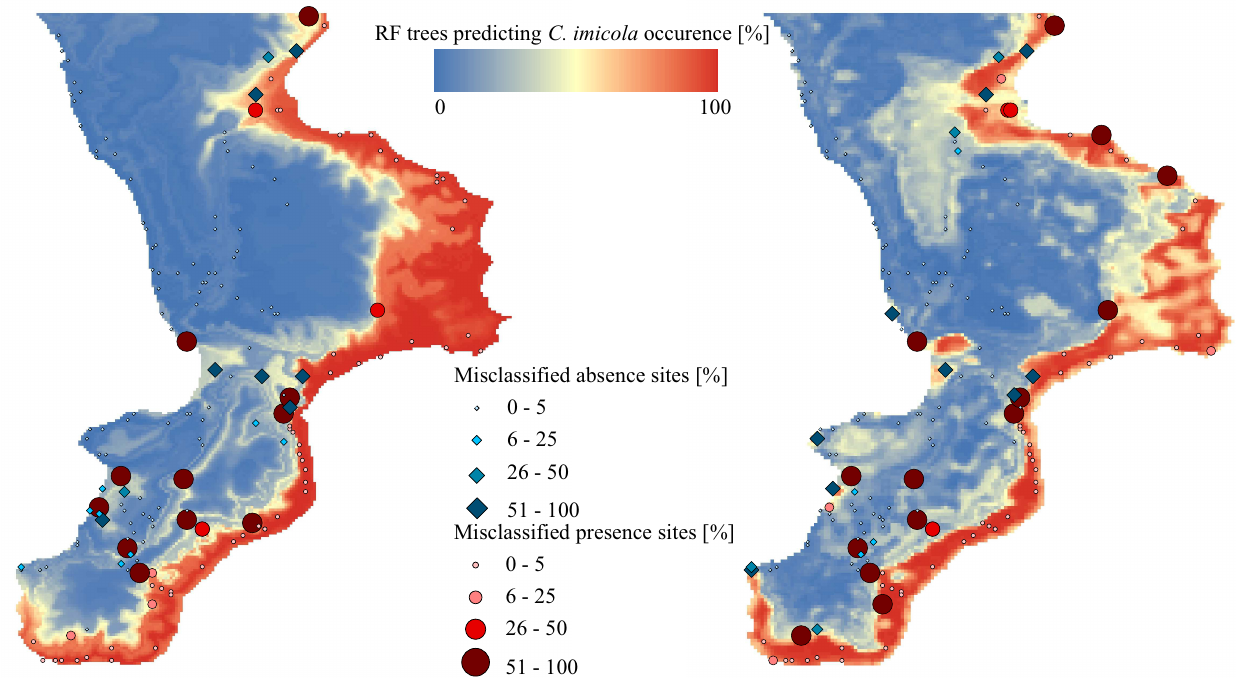
Percentage of RF trees assigning C. imicola occurrence and percentage of misclassifications at absence and presence sites, based on climatic data ( left ) and remotely sensed data ( right